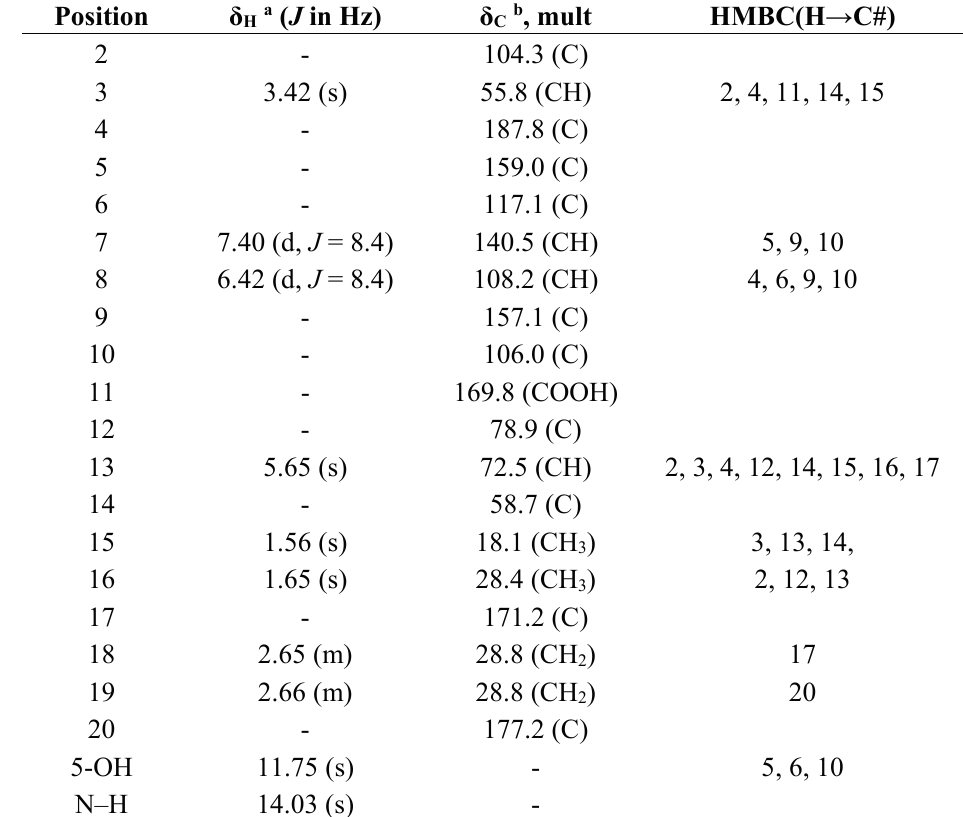
Table 3. NMR Spectroscopic Data for Compound 3 (Cryptosporioptide A) in CDCl 3 - d 6 . Position